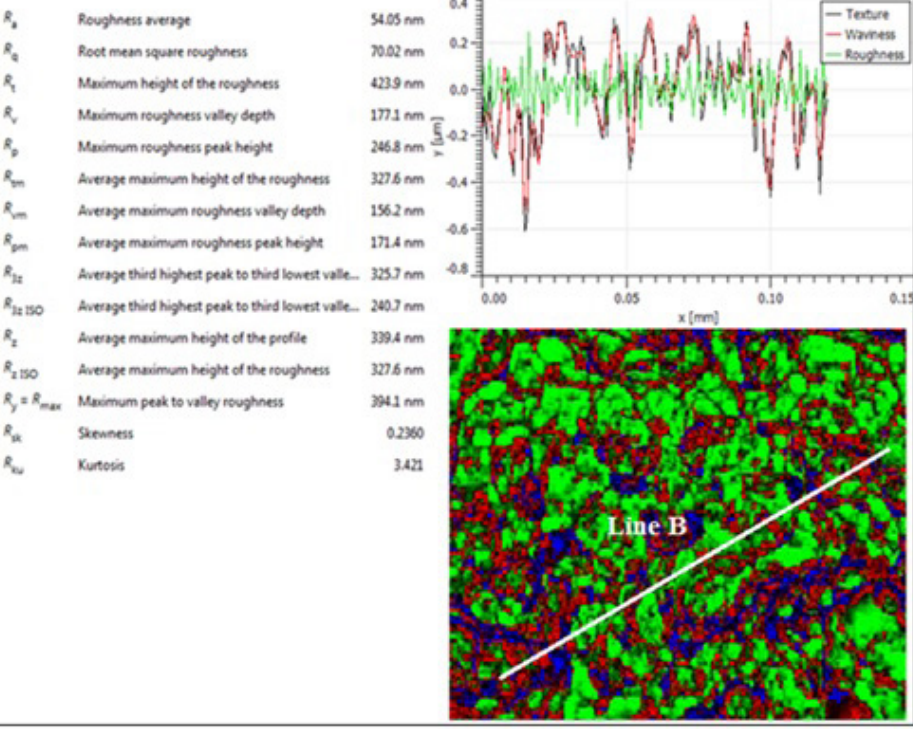
Figure 10. Surface parameters of Nitinol composite at 1000 0 C for 30